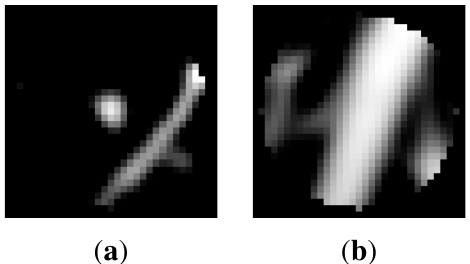
Figure 1. Examples of volume of interest (VOI) areas. ( a ) nodule; ( b ) blood